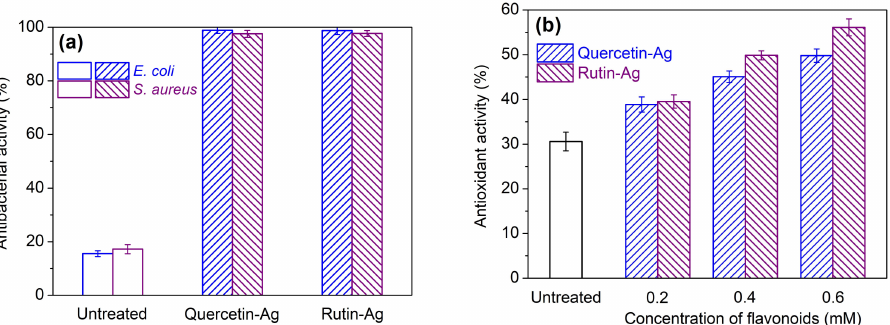
Figure 10. Antibacterial ( a ) and antioxidant ( b ) activities of the AgNPs-treated silk